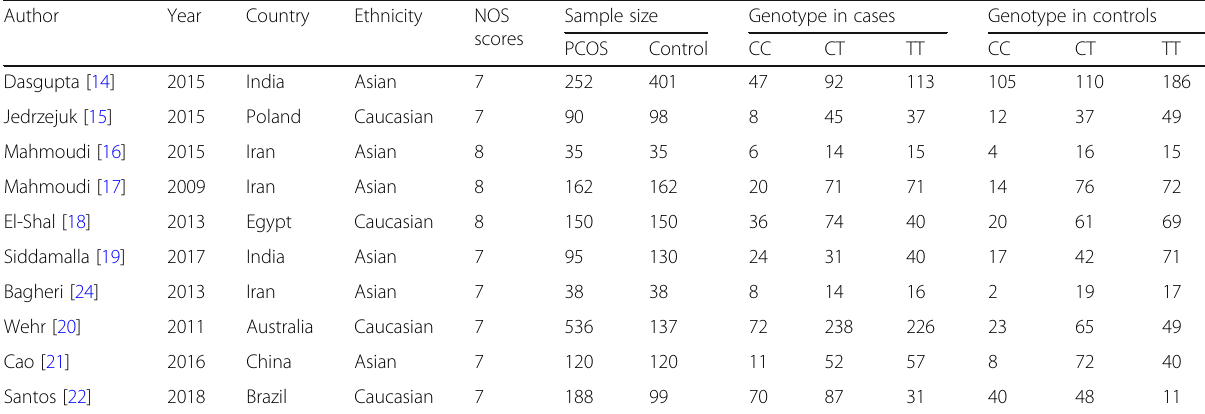
Table 3 Characteristics of studies on VDR TaqI rs731236 (T/C) variant and polycystic ovarian syndrome (PCOS) susceptibility